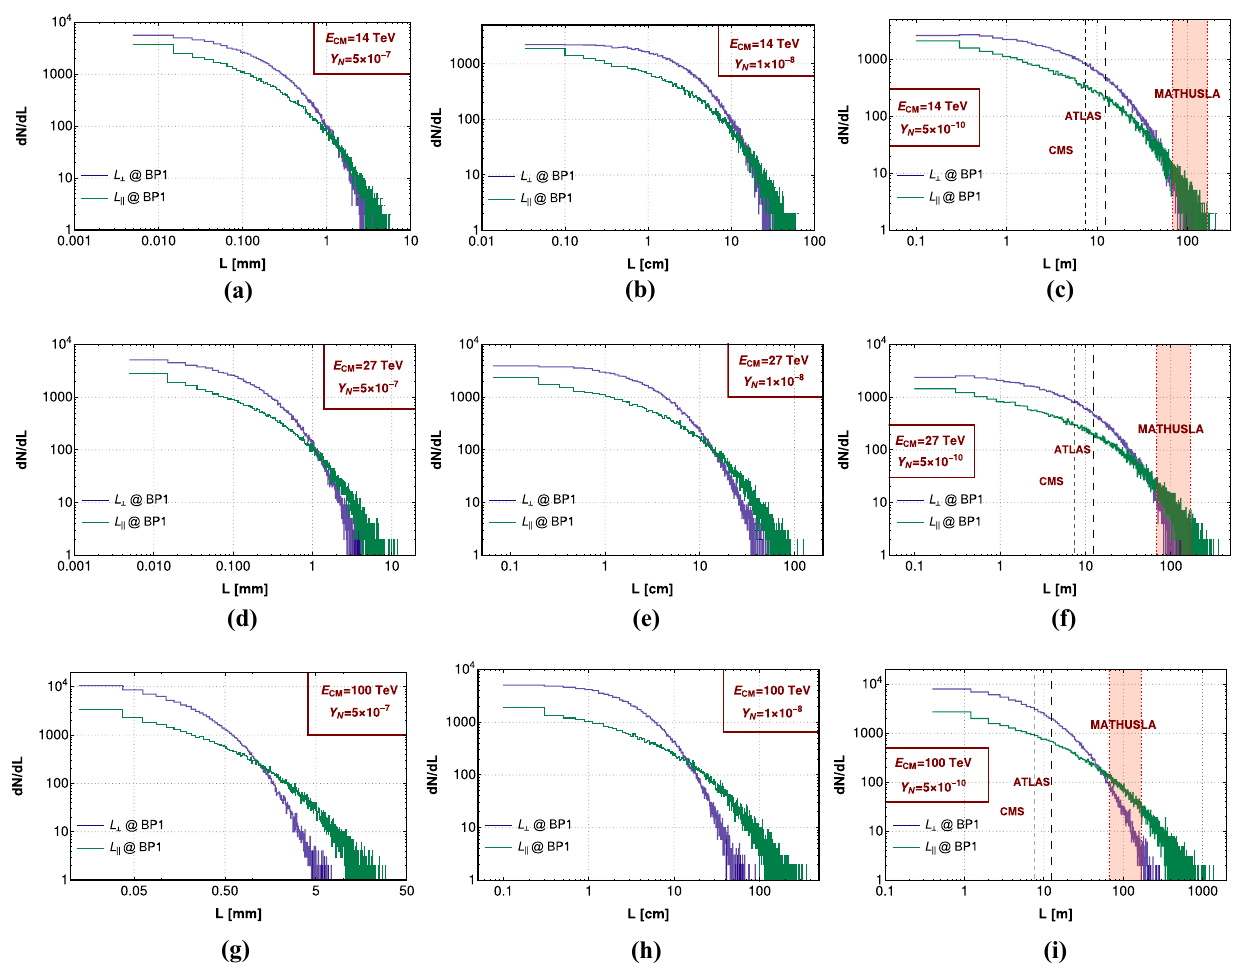
Fig. 13 Displaced total transverse ( L ⊥ in purple) and total longitudi- nal( L || ingreen)decaylengthdistributionsforthe N ± ,comingfromthe pairproductionsattheLHCwiththecentreofmassenergies14TeV( a – c ), 27 TeV ( d – f ) and 100 TeV ( g – i ) for the benchmark points. Yukawa couplings Y N = 5 × 10 − 7 , 1 × 10 − 8 , respectively are used for ( a , d , g )